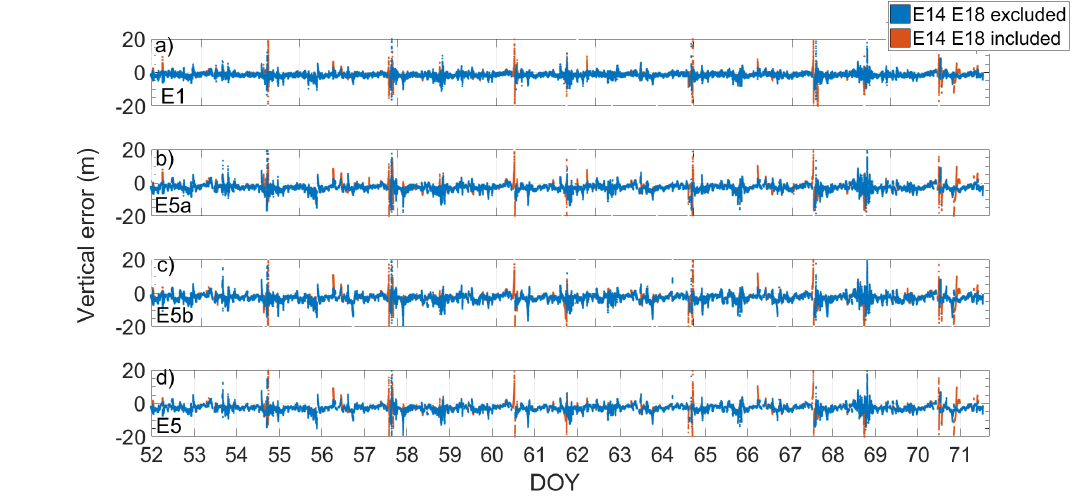
Figure 14. E1, E5a, E5b, and E5 single-point position time series of the vertical error reported in ( a – d ). Blue and red markers represent errors when the solution was obtained by excluding or including the measurements coming from the Milena (E14) and Doresa (E18) satellites, respectively. The solution was achieved by using precise